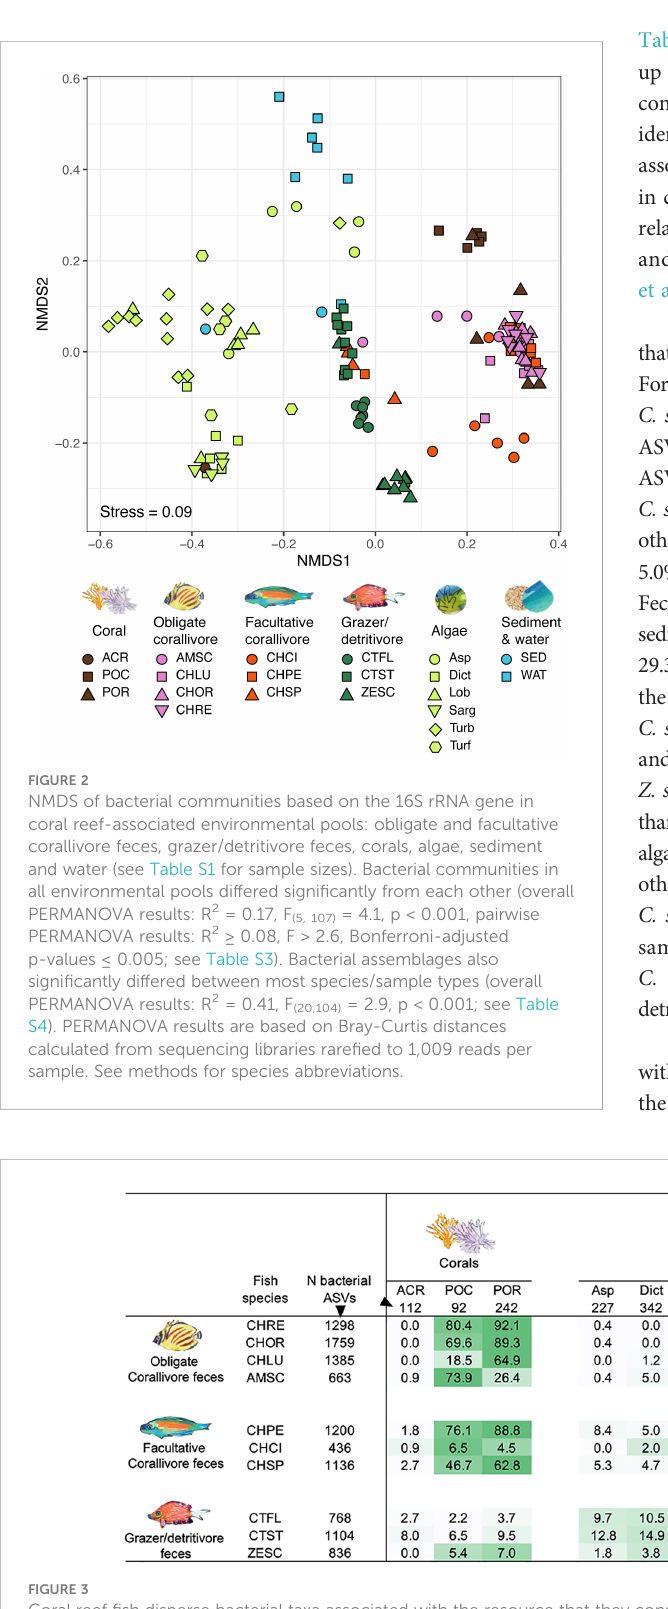
FIGURE 3 Coral reef fi sh disperse bacterial taxa associated with the resource that they consume. Listed are the fractions (%) of bacterial ASVs associated with corals, algae, and sediment and water that are also present in the feces of each fi sh species. Darker shading indicates higher representation of bacterial taxa; shading was scaled for each row ( i.e. , each consumer species) separately. All taxa with less than 100 reads were removed to exclude “ transient ” taxa, and all libraries were rari fi ed to 1,008 reads. All samples per species or environmental pool were pooled (see Table S1 for sample sizes). “ N bacterial ASVs ” indicates the total number of unique ASVs in each environmental pool or fi sh species after rarefaction. See Table S5 for the number of shared ASVs. See methods text for species